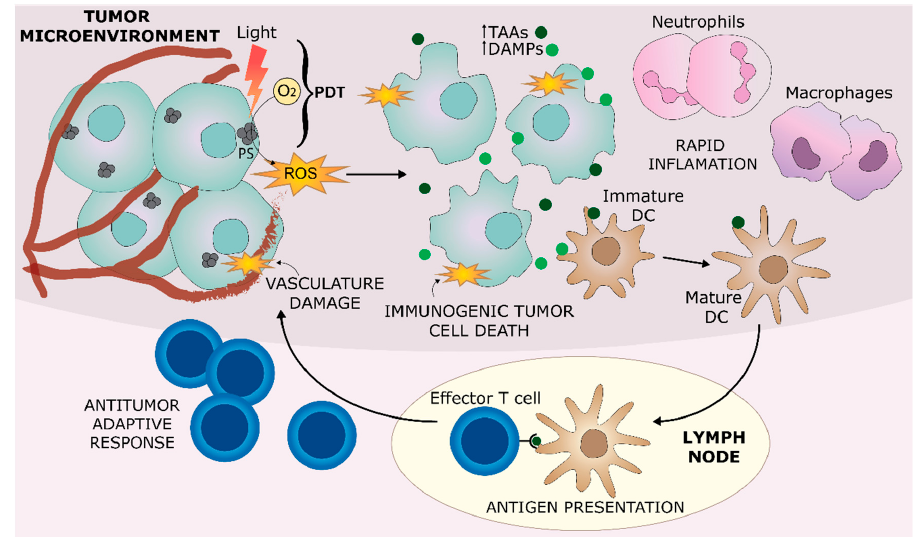
Figure 1. Overview of the antitumor mechanisms of PDT. PDT combines light, oxygen, and a photosensitizer (PS) resulting in the generation of reactive oxygen species (ROS) within tumor cells and tumor-associated vasculature. This leads to a direct cytotoxic e ff ect in tumor cells as well as vasculature shutdown, which in turn results in tumor death due to starvation. This initial tumor destruction triggers a rapid localized inflammation at the tumor site consisting mostly of neutrophils and macrophages. ROS induce an immunogenic tumor cell death (mainly apoptosis and necrosis) that involves exposure / release of damage-associated molecular patterns (DAMPs) from dying